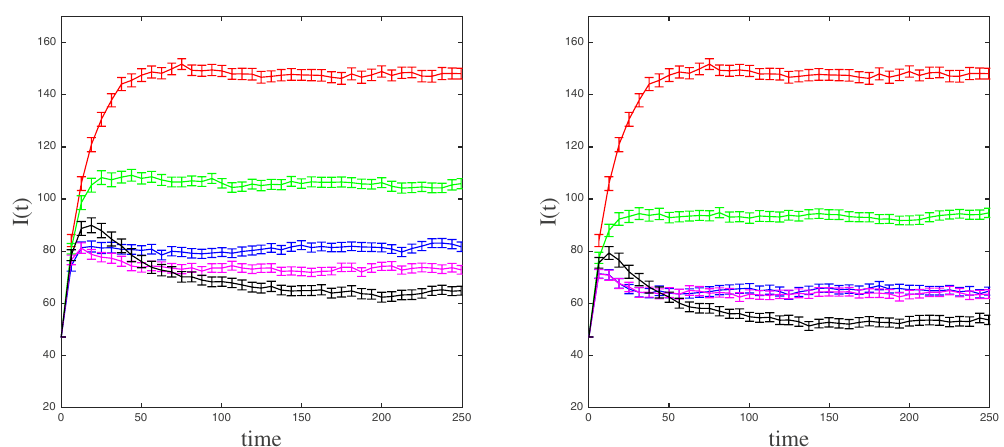
Figure 6. The mean number of infected individuals (and 95% confidence intervals) as a function of time (days) for four selection strategies of 14 (left panel) and 30 (right panel) most central nodes whose infection status it is used to alert the community: SPN (red), Rand (green), DC (blue), WDC (magenta), and EC